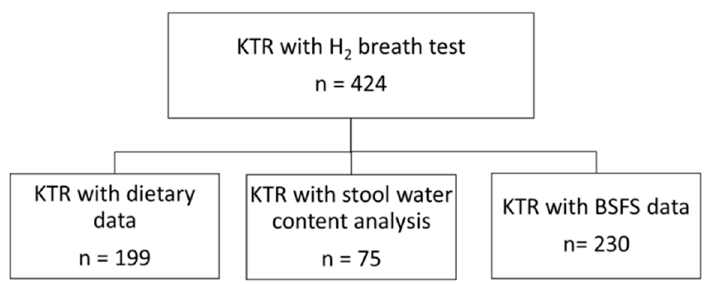
Figure 1. Flowchart diagram. Abbreviations: H 2 , hydrogen; KTR, kidney transplant recipients; BSFS, Bristol Stool Form Scale.